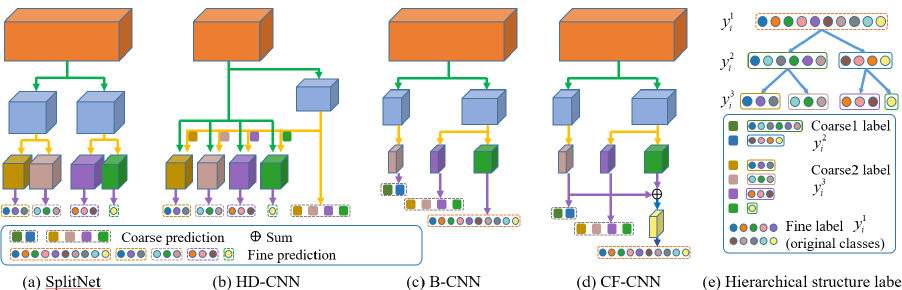
Figure 1. Network structure and hierarchical structure label illustrations. ( a ) SplitNet [22], ( b ) HD- CNN [19], ( c ) B-CNN [20], ( d ) our CF-CNN, and ( e ) hierarchical structure